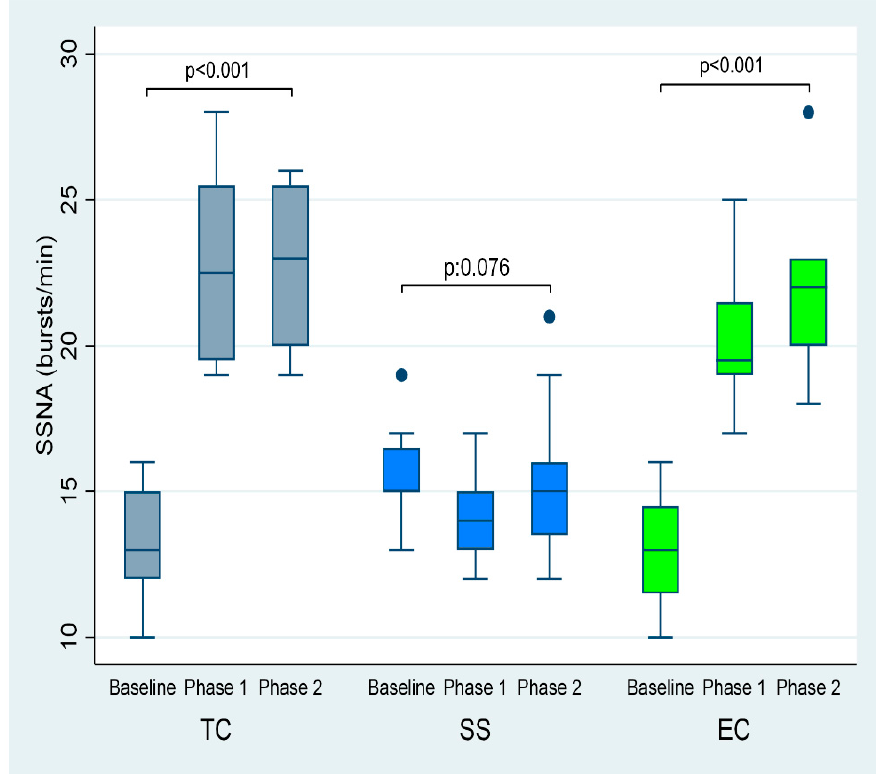
Figure 4. SSNA at baseline and phases 1 and 2 EC and sham smoking. EC, electronic cigarette; SSNA, skin sympathetic nerve activity; TC, tobacco cigarette, SS, sham